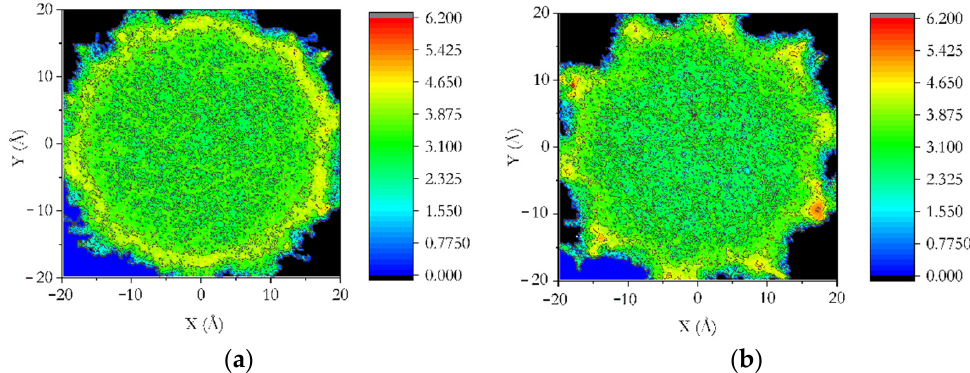
Figure 5. Distribution of 150 methane molecules over 75,000-time frames of MD simulations in ( a ) smooth and ( b ) undulated 4 nm cylindrical pore of amorphous silica.